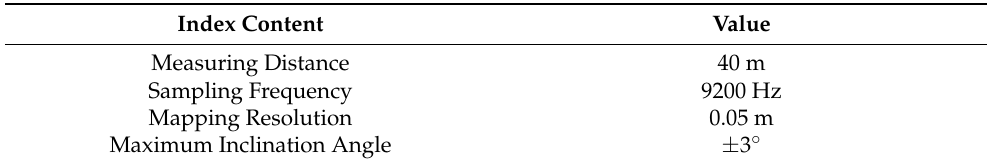
Table 2. SLAMTEC Mapper technical norm.